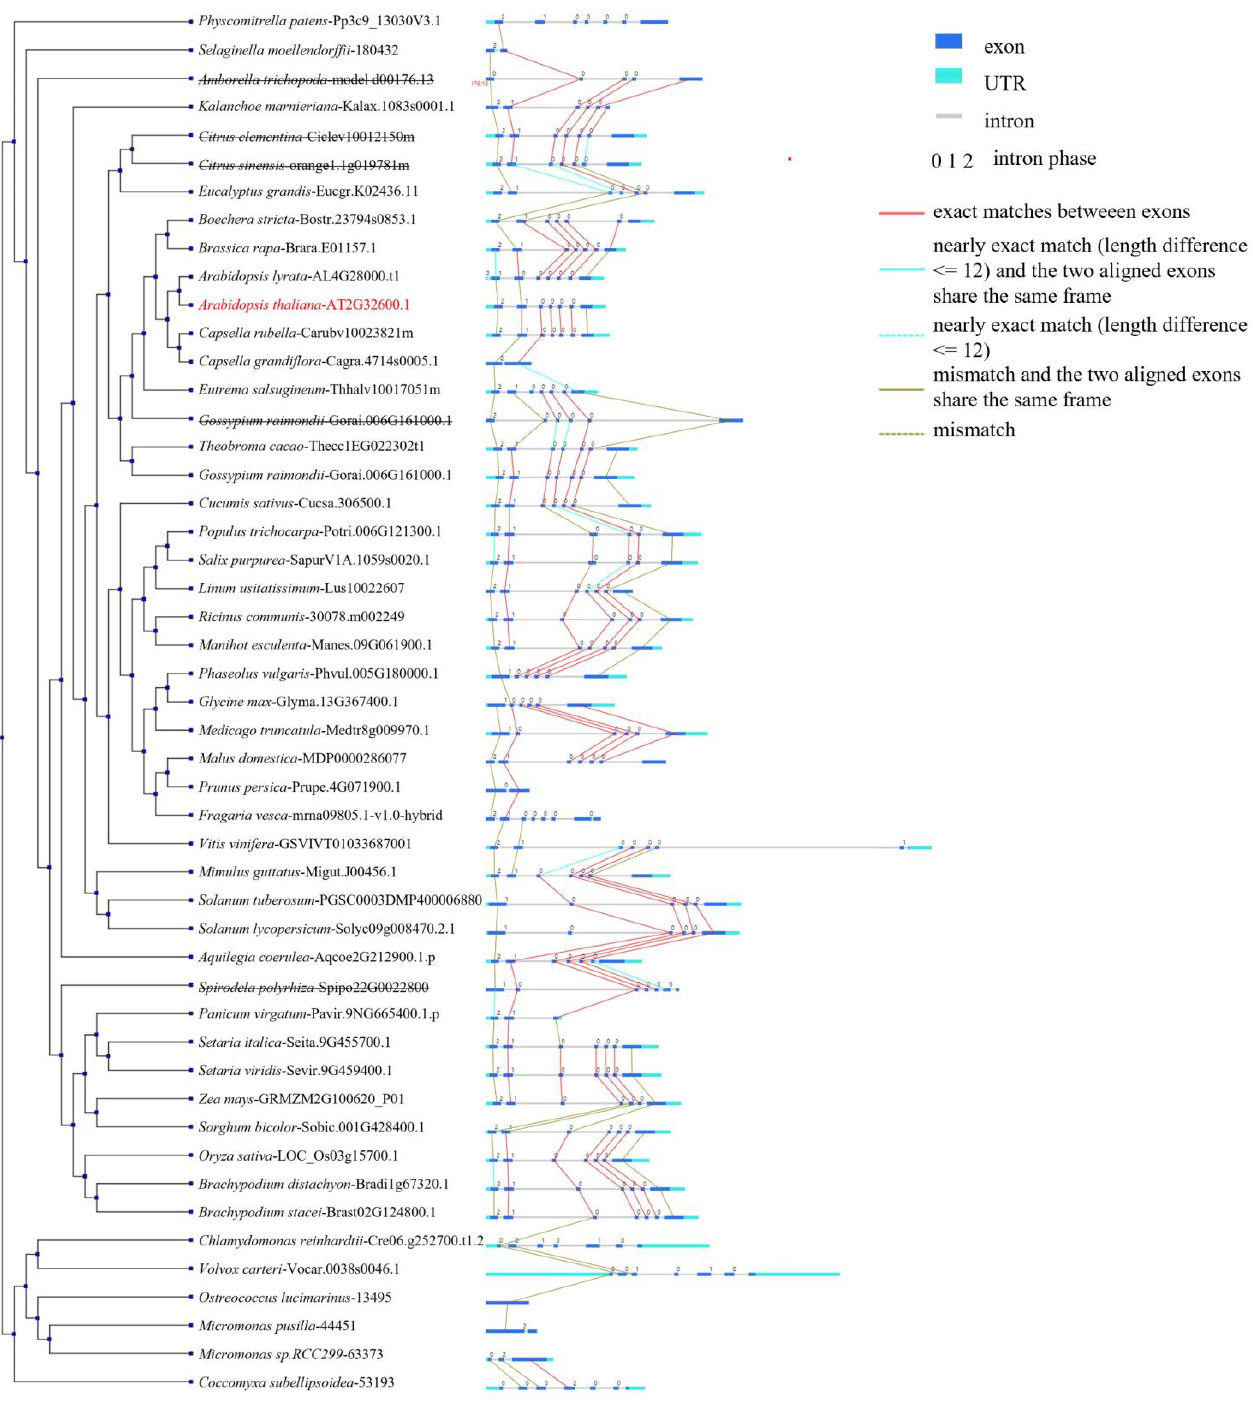
Figure 8. Collinearity of the SF3a2 genomic blocks in representative angiosperm genomes. Collinear- ity analysis results between plant SF3a2s genomic blocks. The species and gene ID are listed in the middle. Blue squares represent CDS, light blue squares represent UTR, gray lines represent introns, and the number at the top indicates the intron phase. The collinearity between different exons is marked by lines of different colors, as shown on the right.